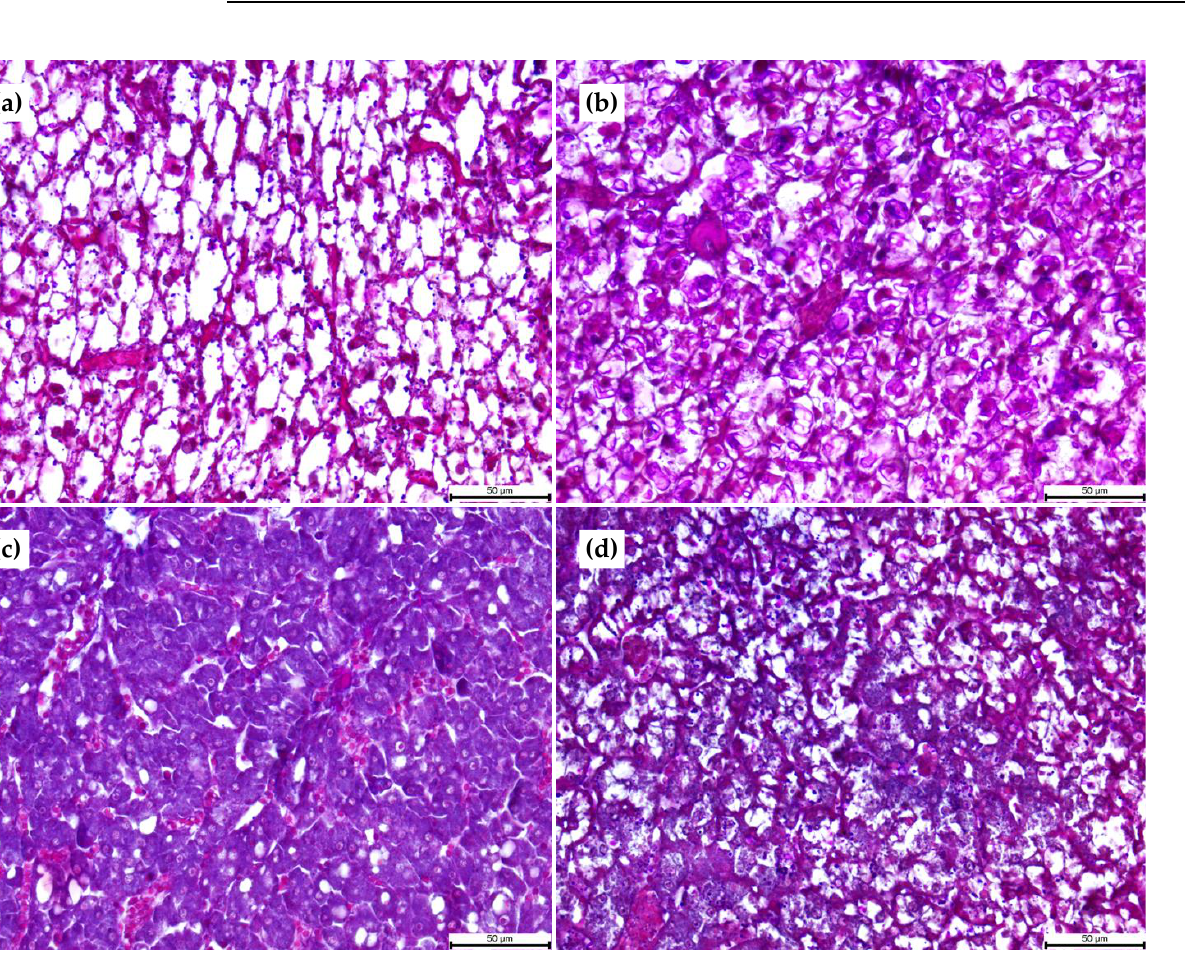
Figure 1. Longitudinal paraffin sections of the liver of P. punctifer (26 dpf) showing different levels of lipid accumulation. ( a ) Individuals fed the 30:15 diet, ( b ) individuals fed the 30:10 diet, ( c ) individuals fed the 45:15 diet, and ( d ) individuals fed the 45:10 diet. Magenta staining in the cytoplasm of hepatocytes indicates the presence of glycogen within cells. Staining: Periodic Acid Schiff (PAS)-Alcian Blue (AB) pH 2.5.